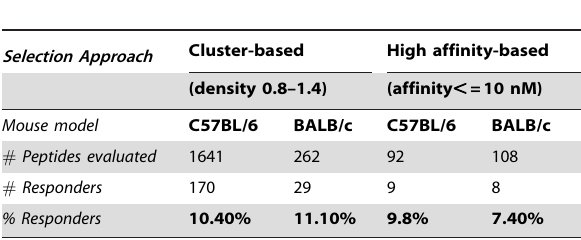
Table 1. Comparison of cluster-based and high affinity-based screens conducted in C57BL/6 and BALB/c mouse